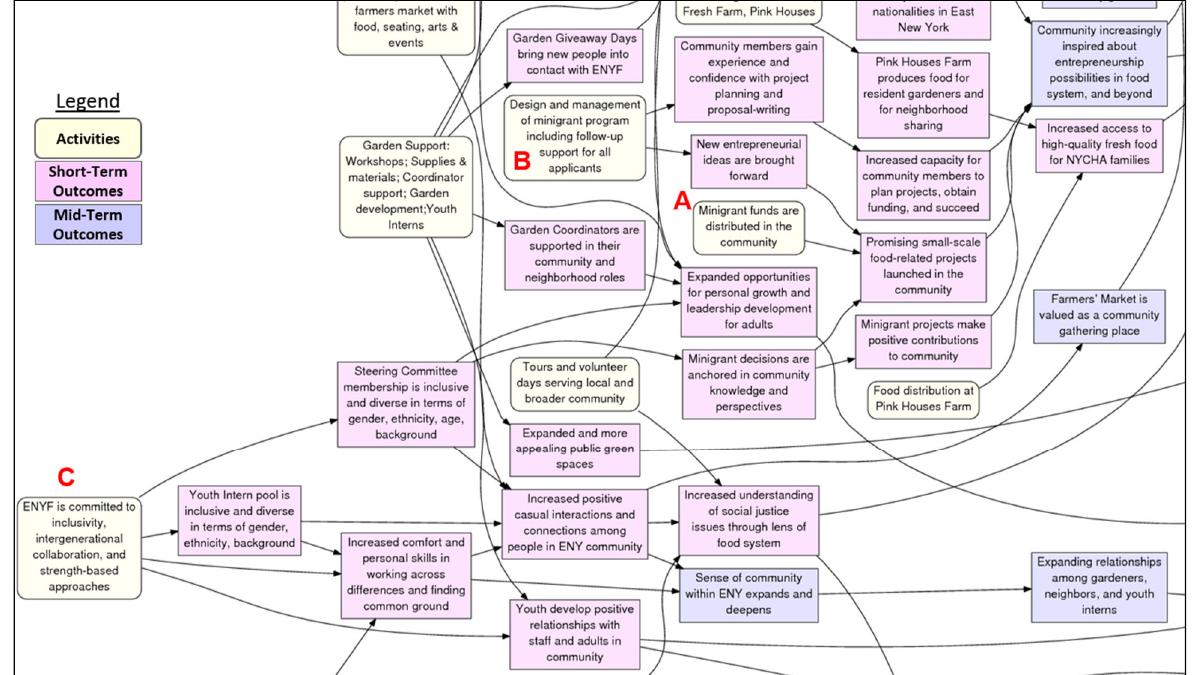
Figure A2. Subsection of East New York Farms! ( ENYF!)’s Collaborative Pathway Model Relating to